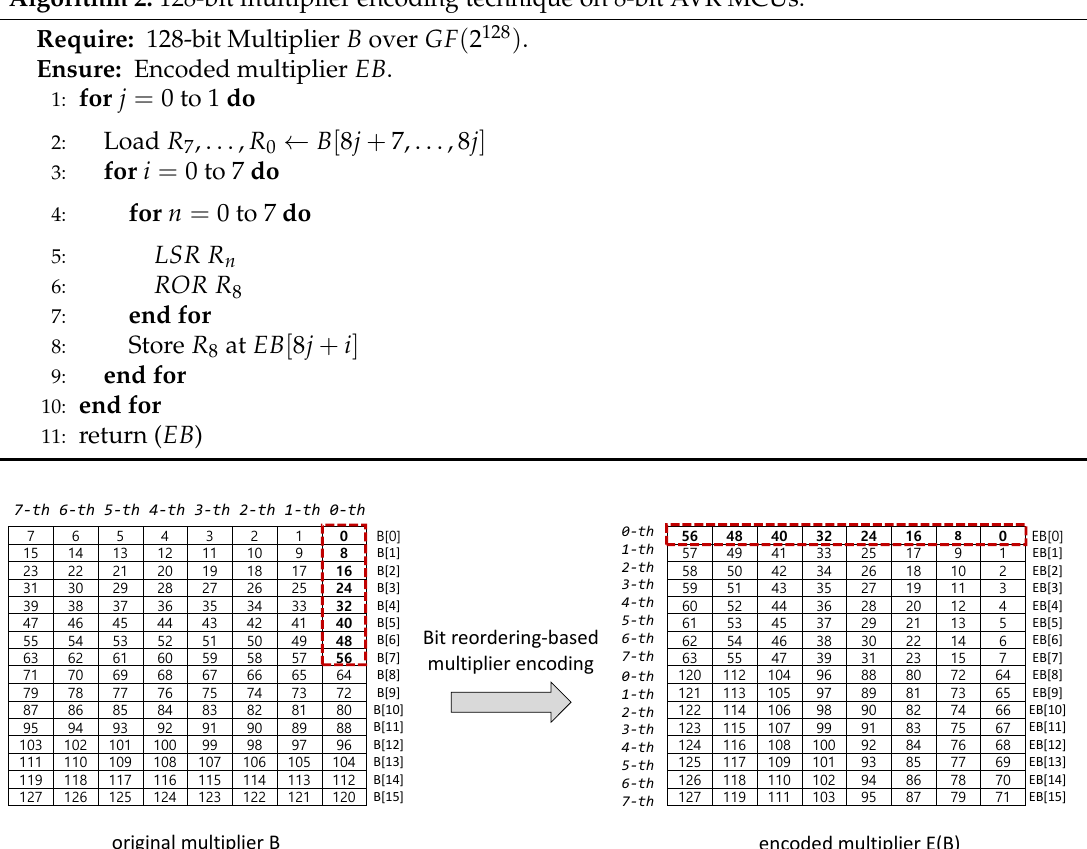
Figure 2. The result of the 128-bit multiplier encoding process. Left -side: original input multiplier, Right -side: encoded multiplier.